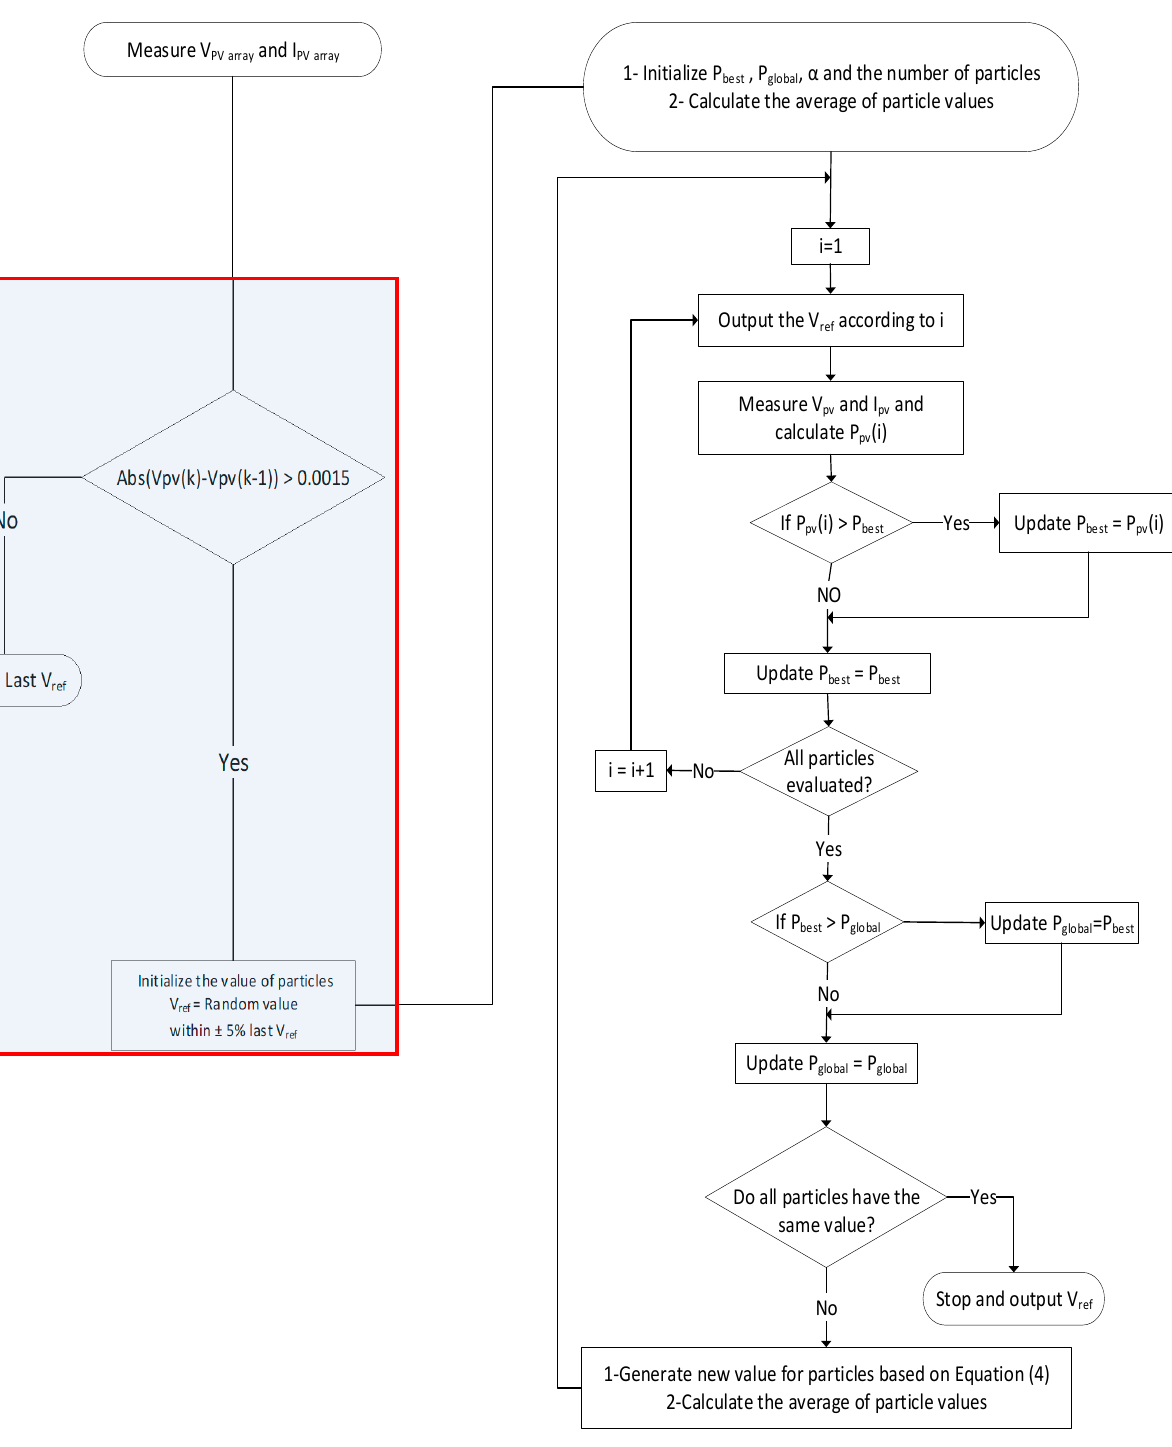
Figure 1. Flow diagram of the proposed MPP tracking method based on the BES technique. After the modifications made in the GMPP BES-based method, the algorithm could continuously monitors the changes in the PV array’s voltage, current, and power to determine whether the system was experiencing a universal change in insolation and ambient temperature. The algorithm fed the right initial values of particles to the GMPP search process steps upon the added condition being met. After feeding the appropriate initial values of particles, according to Equation (4), the average value of the particles was calcu- lated before calculating the new values of the particles. Following that, each particle